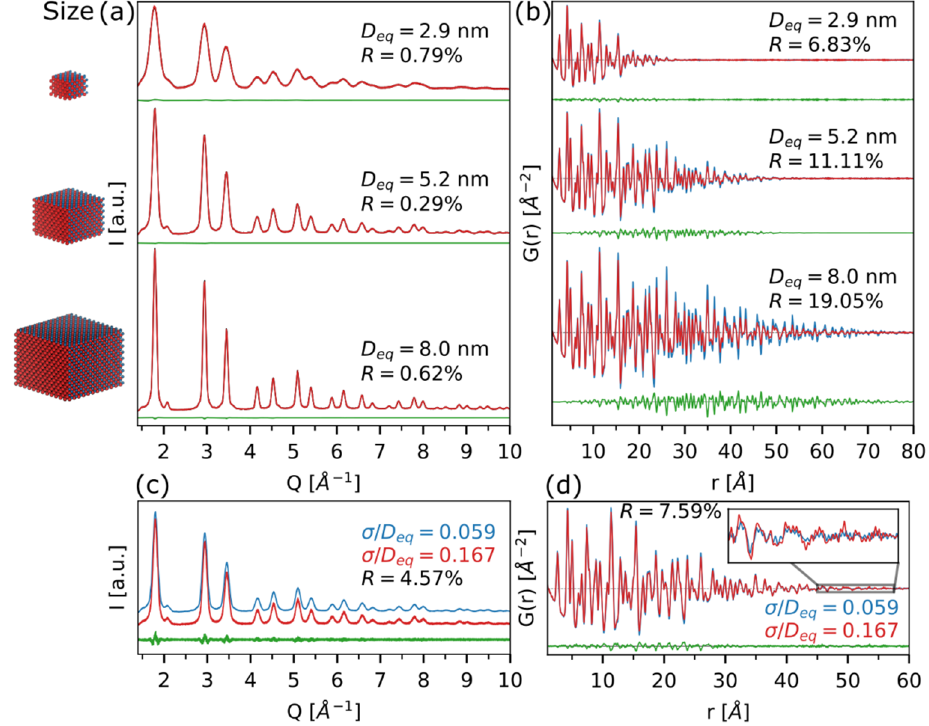
Figure 3. Simulations in reciprocal (DSE, first column) and real (PDF, second column) spaces for CdSe atomistic models, with different sizes ( a , b ) and size dispersions at a constant nanocrystal size (5.2 nm) ( c , d ). In ( a , b ), the difference trace (green line) is computed against the ideal simulation (without IRF convolution), while in ( c , d ), it is the difference between the monodisperse population (blue line) and the polydisperse one (red trace), both with the proper IRF convolution. An agreement factor, computed as 𝑅 = (cid:4678)(cid:3495) 2 ∑ N × 100 (where I r is the reference simulation, and I w the work model) is also reported. Further details on the size and shape of CdSe atomistic models are given in Table